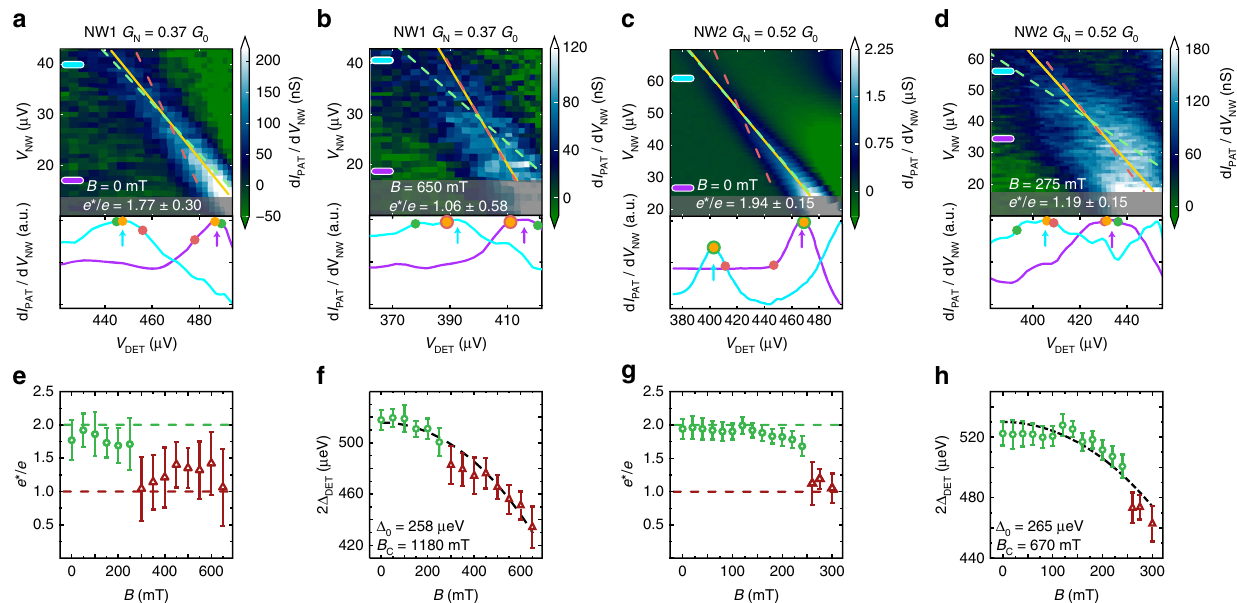
Fig. 2 Magnetic fi eld-induced 4 π -periodic Josephson radiation. Differential transconductance d I PAT /d V NW as a function of V NW and V DET for devices NW1 ( a , b ) and NW2 ( c , d ) at zero and fi nite magnetic fi elds, respectively. The position of the transconductance peak maps the frequency of the monochromatic Josephson radiation. A linear fi t e * V NW = 2 Δ DET - eV DET through these peaks is shown as an orange line. Dashed green and red lines show linear fi ts with a fi xed slope corresponding to e * = 2 e and e * = e , respectively. The shaded regions show the regimes where the fi t of the transconductance peak is not reliable, see text. Two normalized and smoothed horizontal linecuts are plotted, where arrows point to the position of the extracted peaks. The orange, green, and red dots denote the position of the best fi t, the e * = 2 e fi t, and the e * = e fi t, respectively. The evolution of e * ( B ) and 2 Δ DET ( B ) is presented in ( e , f ) for NW1 and in ( g , h ) for NW2. For the calculation of the error bars, see text and Supplementary Note 2. The transition from the 2 π - to 4 π -periodic Josephson radiation is observed between 175 and 300 mT as e * evolves from values near 2 e (green circles) to values close to 1 e (red triangles). For all devices, 2 Δ DET ( B ) drops monotonically (black dashed line, see text), independently of the change in e